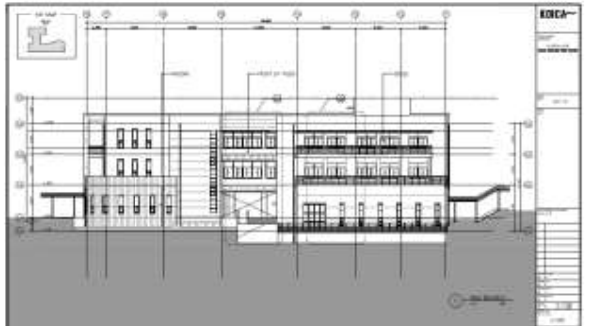
Figure 9. Koica building as build